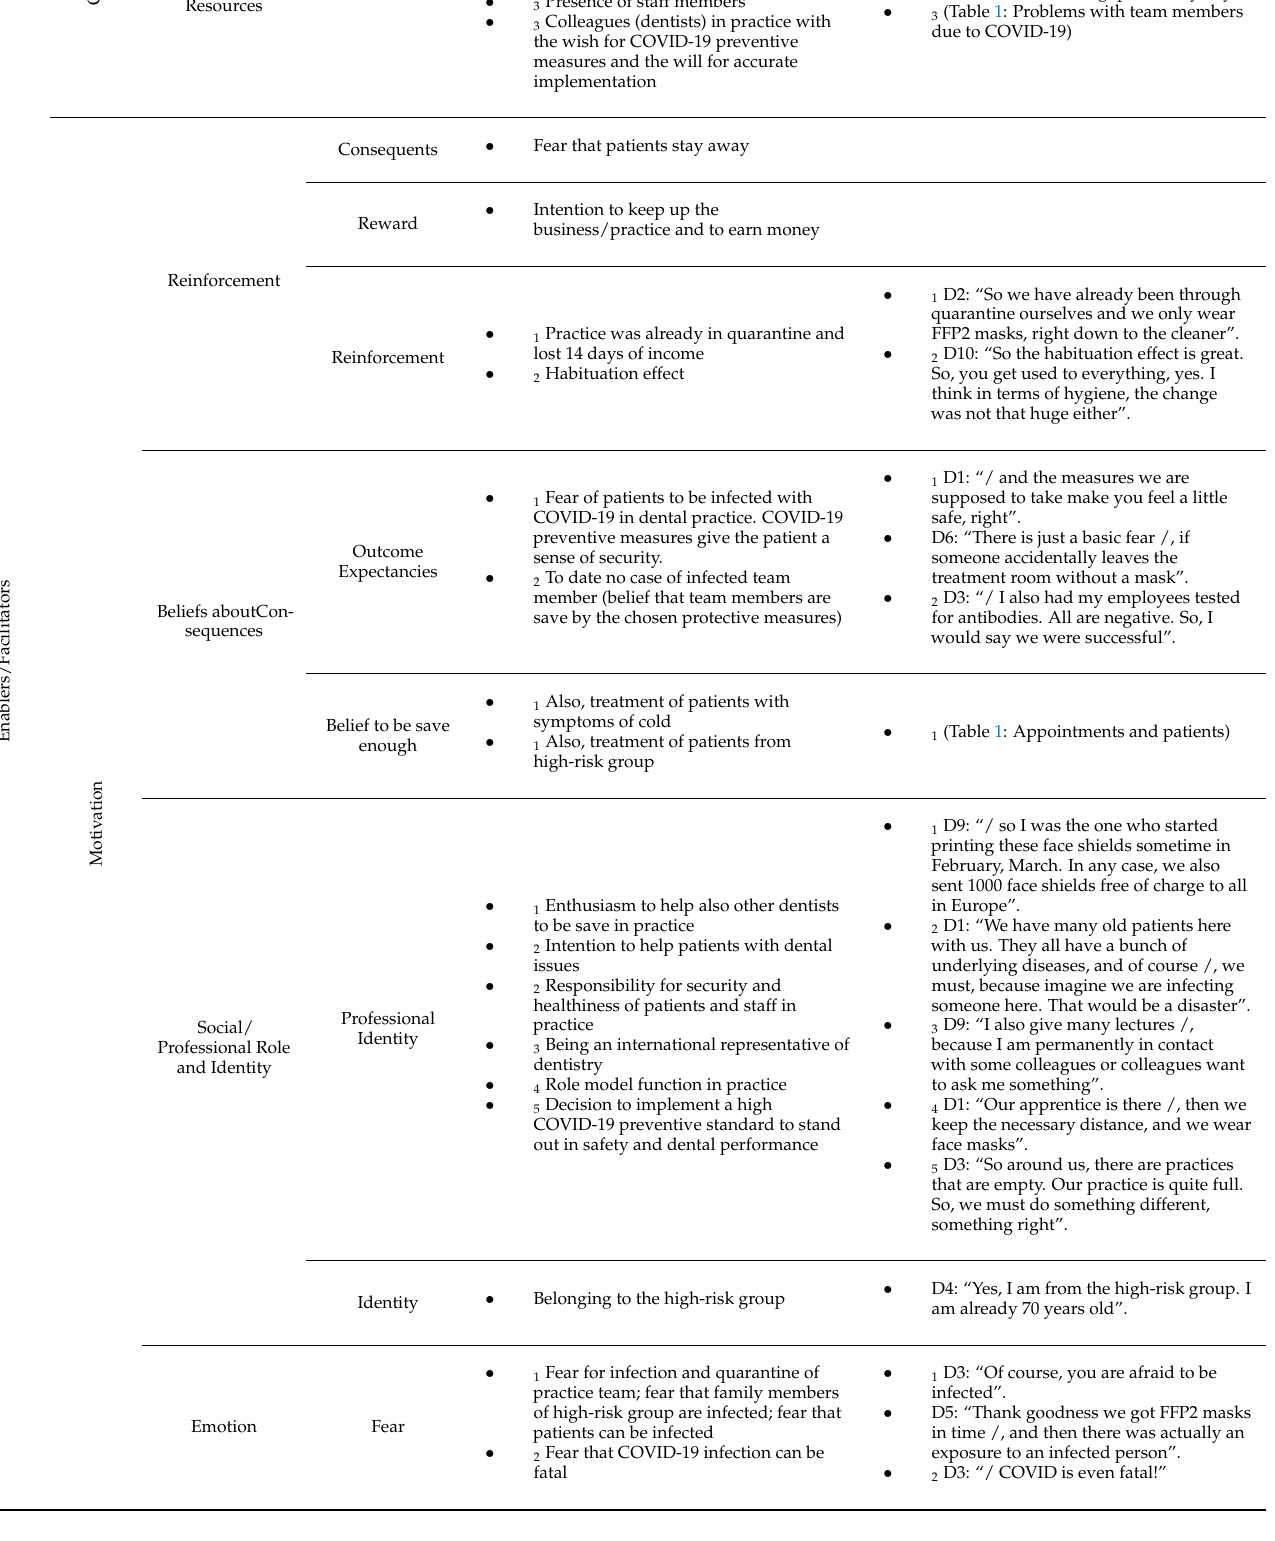
3 (Table 1: Problems with team members due to COVID-19)